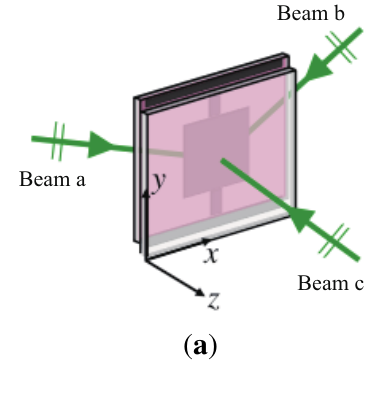
Figure 1. ( a ) Configuration of three-beam interference holographic polymerization and ( b ) its wave number ( k -space)